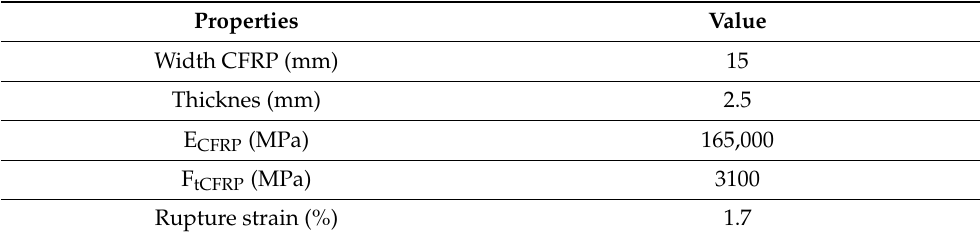
Table 3. Mechanical properties of the reinforcing system CFRP strips.